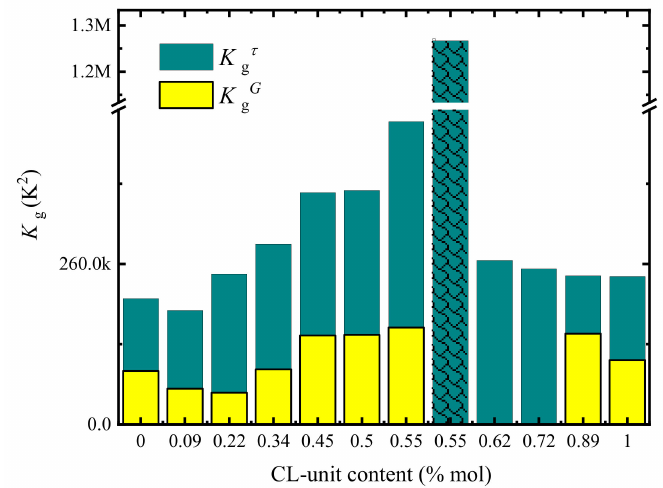
Figure 14. K g values versus copolymer composition calculated from PLOM experiments ( K gG ) and DSC experiments ( K g τ ) for MM W -BS x CL y samples. This plot was reported in ref. [38]. On the PBS-rich side, K gG and K g τ values increased with the CL-unit molar content, since the growth rate decreased and the nucleation rate increased with comonomer in- corporation. On the PCL-rich side, where nucleation and growth rates show opposite trends, there is a counterbalance between nucleation and growth, which causes the K g τ values to remain almost constant with composition. These results prove that there is a clear asymmetry depending on which side of the pseudo-eutectic region the composition